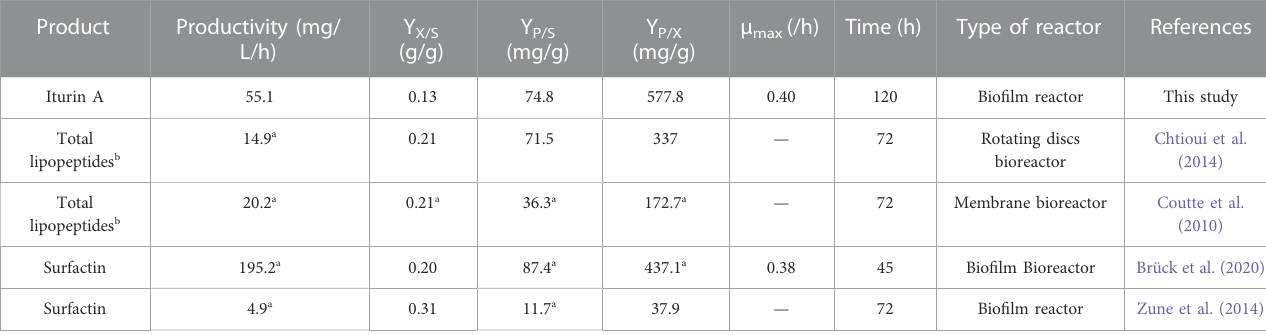
TABLE 3 Comparison of parameters for production of lipopeptides in bioreactor.